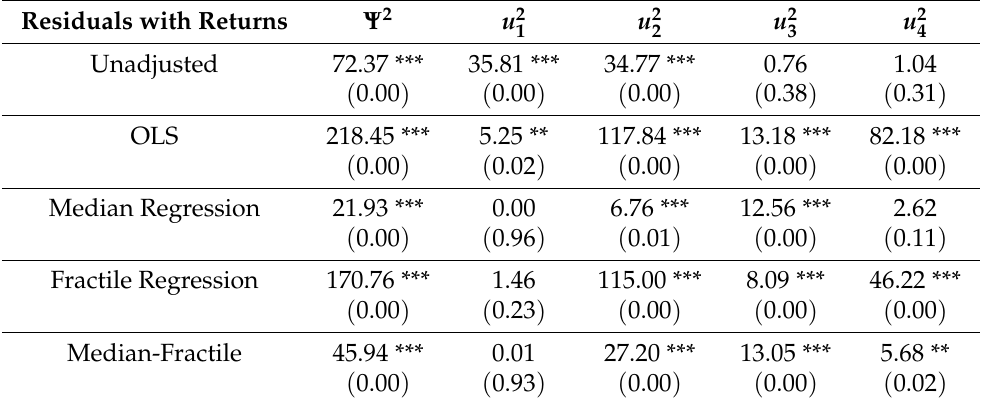
Table 7. Smooth statistics and p -values (sample m =